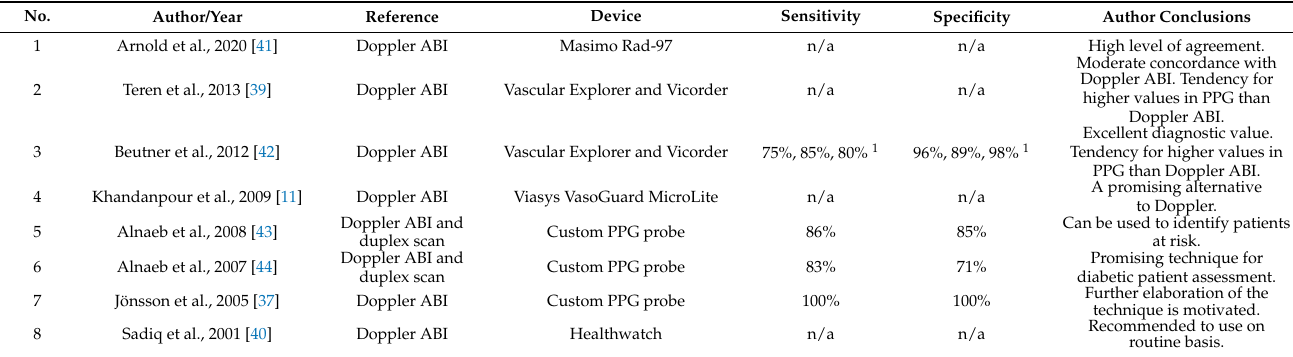
Table 2. Studies on photoplethysmography ABI devices.